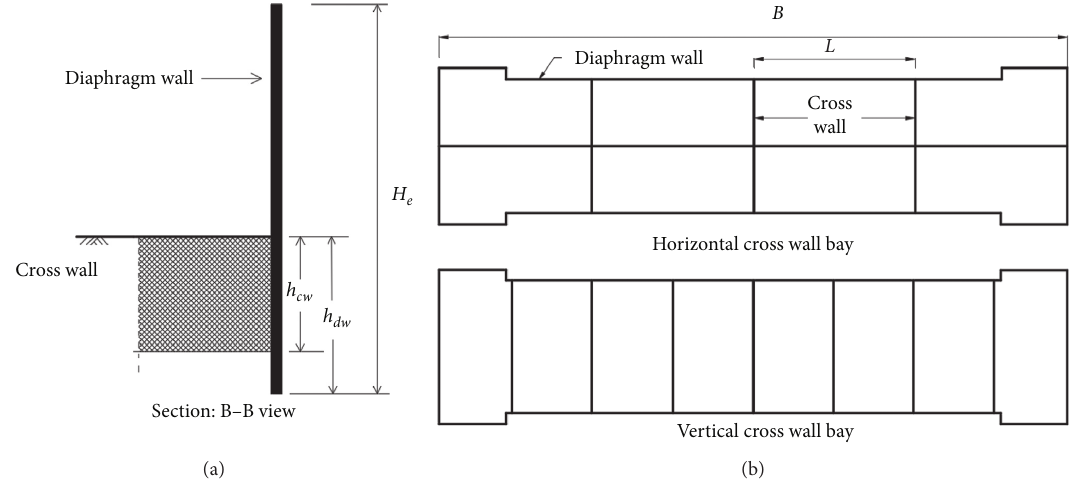
Figure 15: Schematic diagram of the target optimization parameters for retaining. (a) Embedded depth of walls. (b) Geometric parameters of the cross wall.